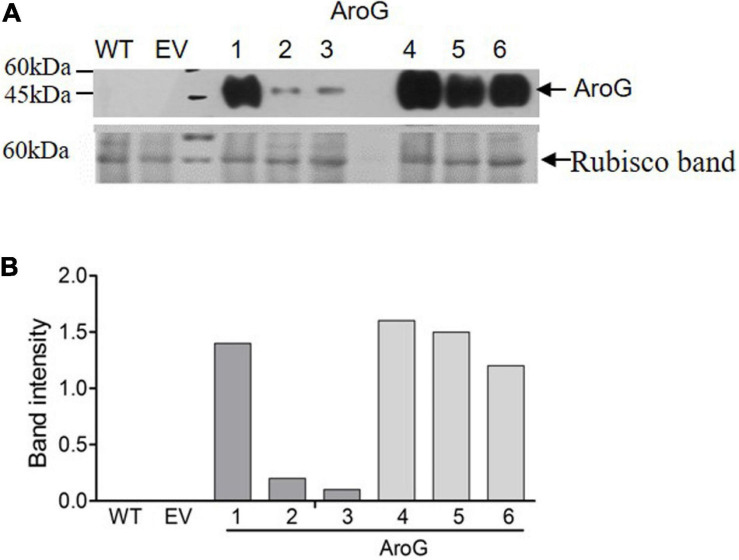
Expression level of bacterial AroG in transgenic tobacco plants. (A) Immunoblot analysis of protein extracts from the leaves of WT, EV and transgenic plants expressing AroG using anti-HA antibodies. Lower panel: coomassie brilliant blue staining used for equal loading; the rubisco band is marked by an arrow. The marker size is shown on the left. (B) The graph represents band intensity obtained from the immunoblot analysis that was normalized to the rubisco band as measured by ImagJ.